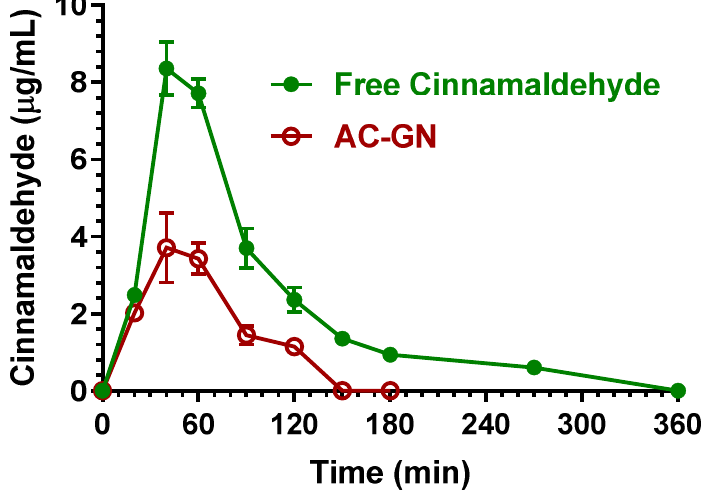
Figure 8. Blood cinnamaldehyde concentrations (μg/mL) within 360 min after oral administration of 400 mg/kg doses to rats. Data are expressed as the mean ± SE of four independent experiments. The oral formulations consisted of dissolved cinnamaldehyde in corn oil (free Cinnamaldehyde) or cinnamaldehyde adsorbed in vegetal fibers (AC-GN).